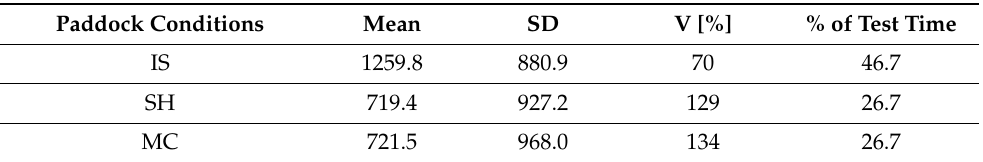
Table 1. Mean time (s) spent by the horses in different paddock areas during 2700 s of the test. Means do not significantly differ ( p > 0.05). Paddock Conditions Mean SD V [%] % of Test Time IS 1259.8